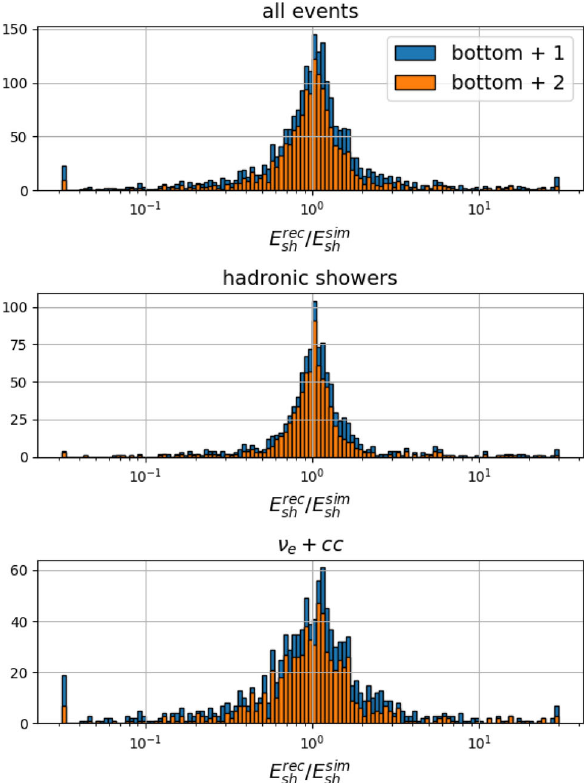
Fig. 14 Ratio between reconstructed and actual shower energy for all events (top), hadronic showers (middle) and charged-current interac- tions of electron neutrinos (bottom). Shown are results of events where at least one of the channels at ∼ 100 m as well as at least one (blue) or at least two (orange) of the other channels on the power string detected a signal with SNR ≥ 2 . 5. The outermost bins are overflow bins